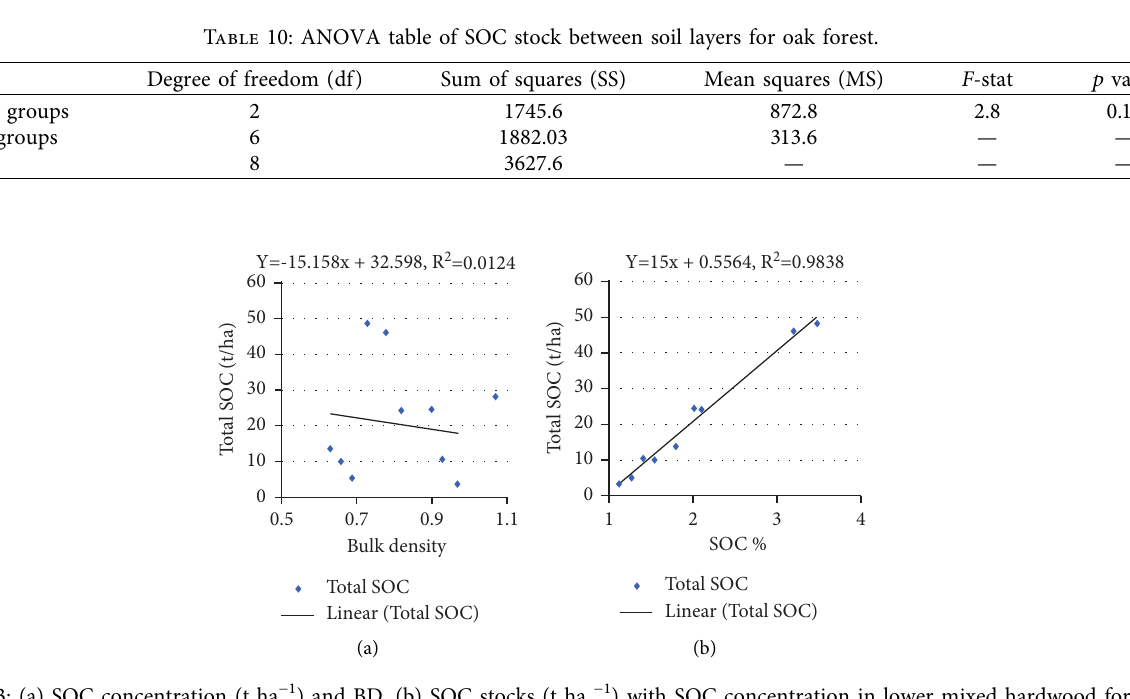
Figure 3: (a) SOC concentration (t ha − 1 ) and BD. (b) SOC stocks (t ha − 1 ) with SOC concentration in lower mixed hardwood